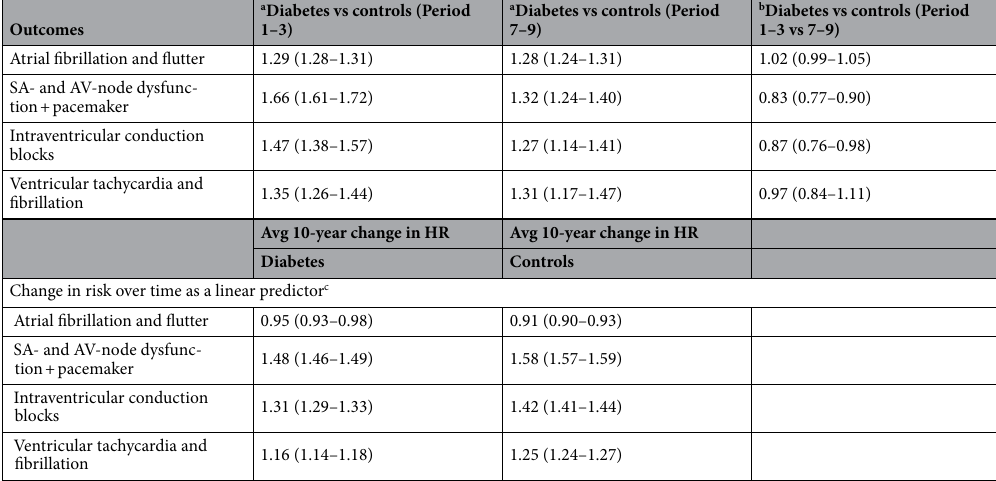
Table 2. Cox regression to estimate change in risk for cardiac arrhythmias in patients with type 2 diabetes and matched controls. The analyses based on Cox regression were adjusted for age, time-updated time periods, sex and interaction terms. Estimates are presented as hazard ratios and 95% confidence intervals. a Excess risk for patients with diabetes and controls in first- and last time periods. b Excess risk for patients with diabetes compared with controls in first- and last time periods. Values are ratios of hazard ratios for patients with type 2 diabetes as compared with during a 10-year period. Values below 1.0 indicates that lesser event-rate reduction. c Excess risk for patients with diabetes and controls, during a 10-year interval,